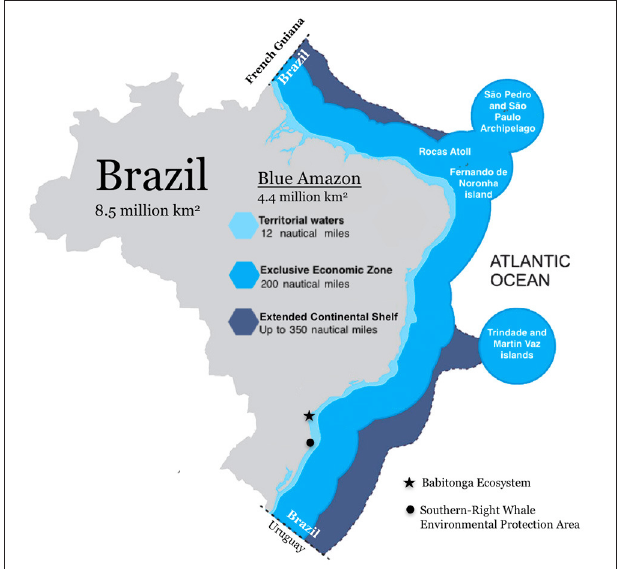
FIGURE 2 | The Brazilian “Blue